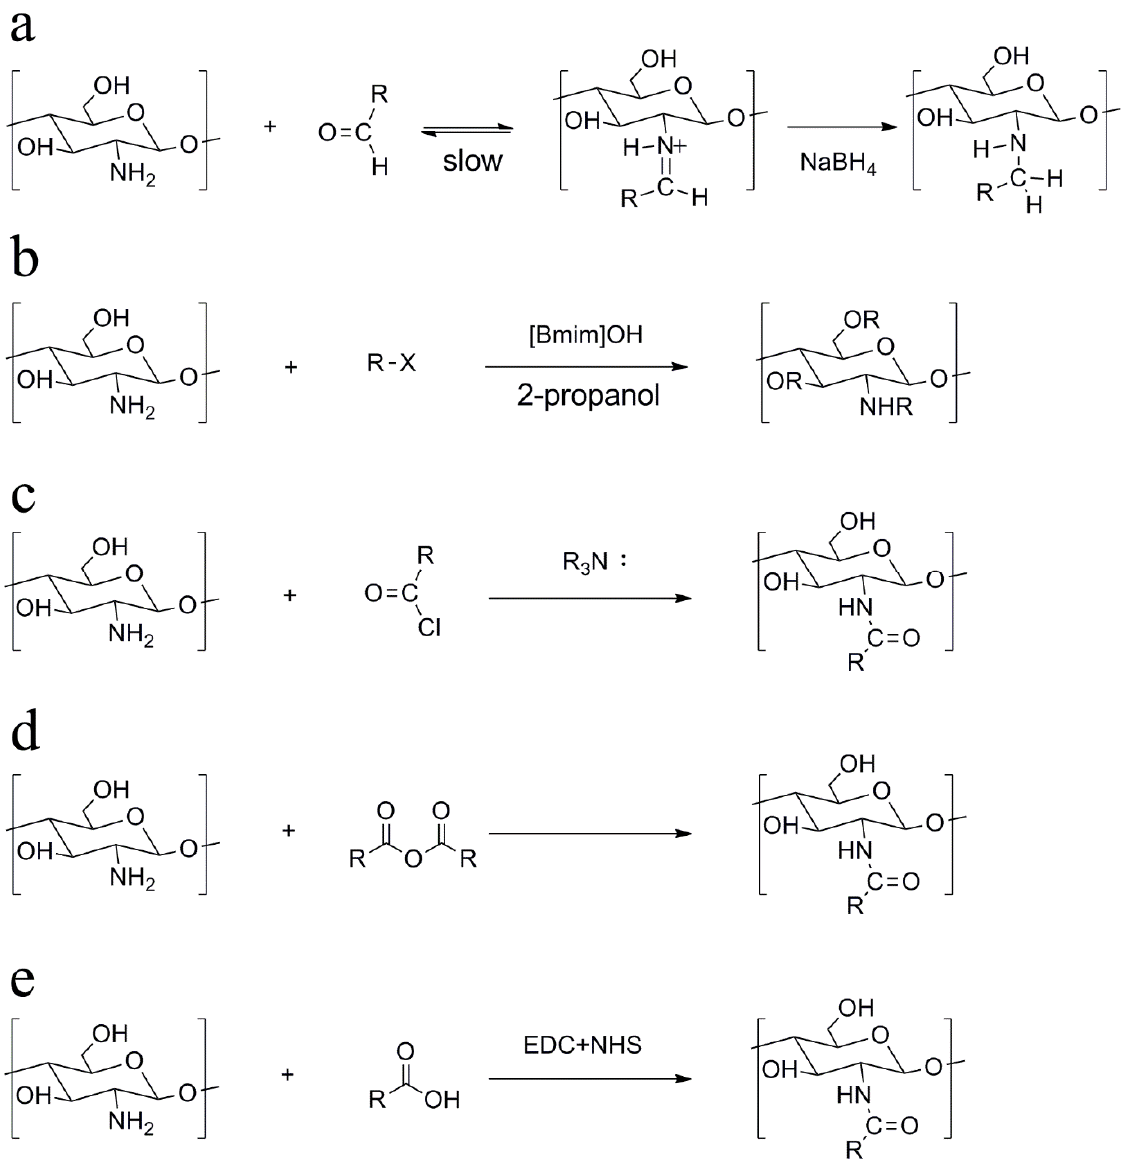
Figure 1. Scheme of alkylated chitosan through different chemical reactions: ( a ) reductive alkylation, ( b ) alkylation through haloalkanes and amino reaction, ( c ) alkylation with acyl chlorides, ( d ) alkylation with anhydrides and ( e ) alkylation with fatty acids.